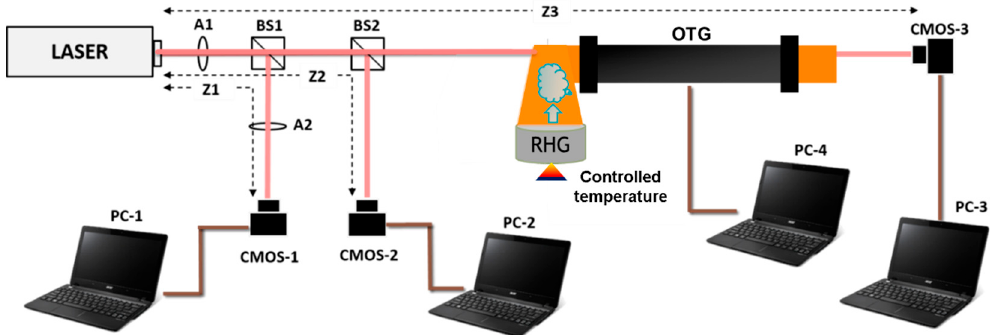
Figure 3. Experimental setup. A#: Density neutral filter. BS#: Beam Splitter #. CMOS#: CMOS Camera to acquire beam at Z 1 = 1.18 [m], Z 2 = 1.45 [m] and Z 3 = 3.97 [m]. OTG: Optical Turbulence